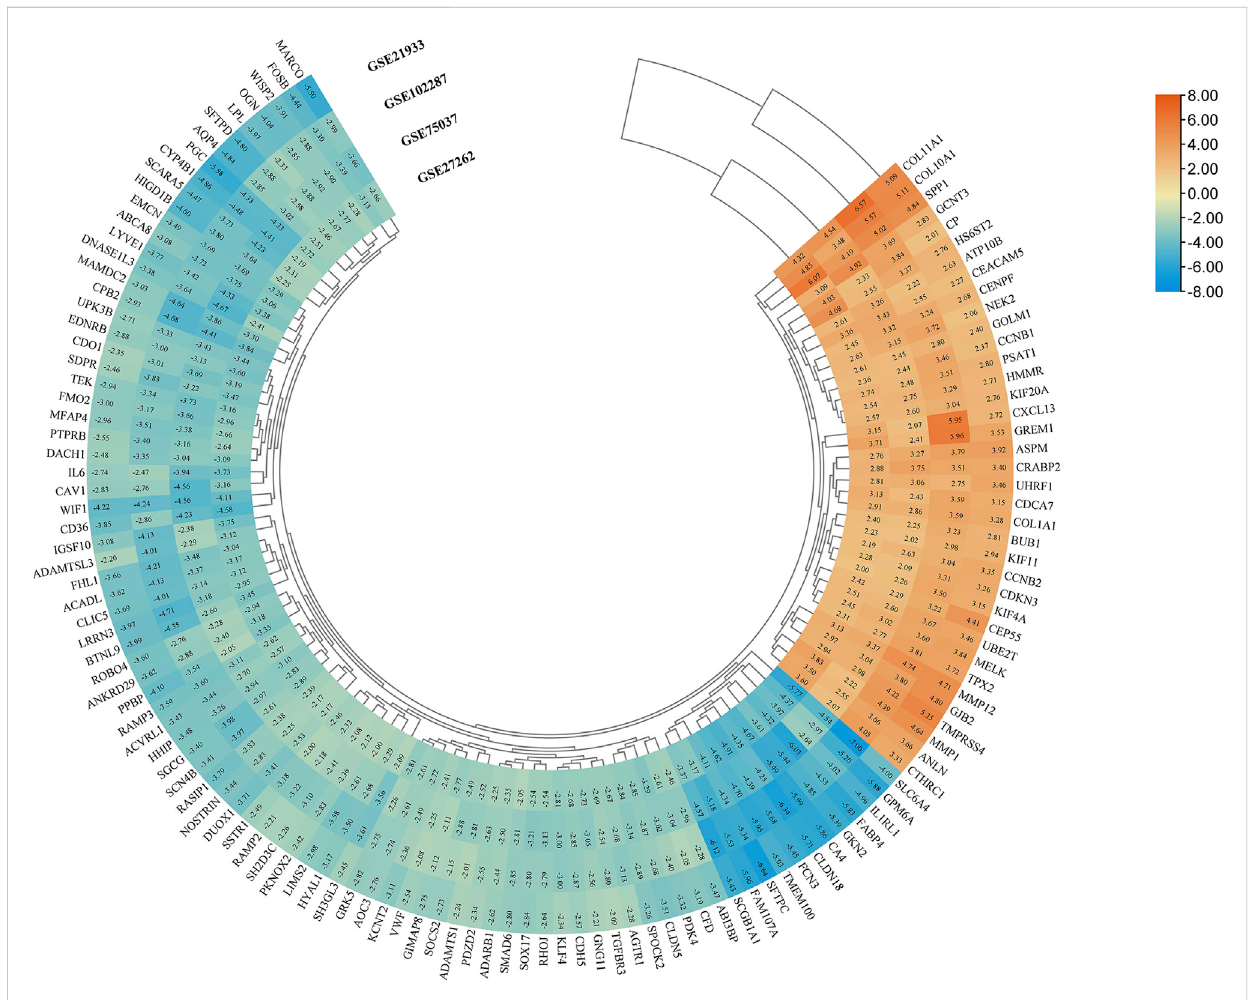
FIGURE 1 Screening of DEGs in four gene expression datasets (|logFC| > 2 and p < 0.05). Heatmap of all overlapping DEGs. Upregulated DEGs, orange; Downregulated DEGs, blue; logFC, log fold change; DEG, differentially expressed